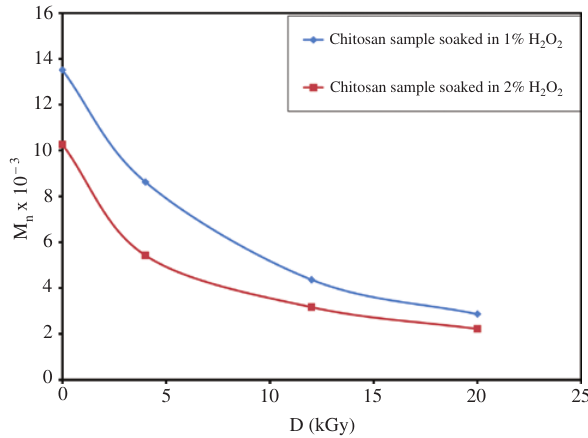
of chitosan and the n